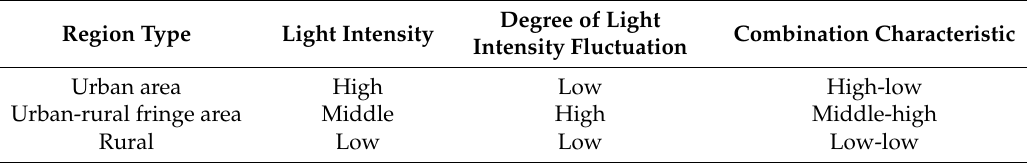
Table 1. Regional classification and light characteristics in